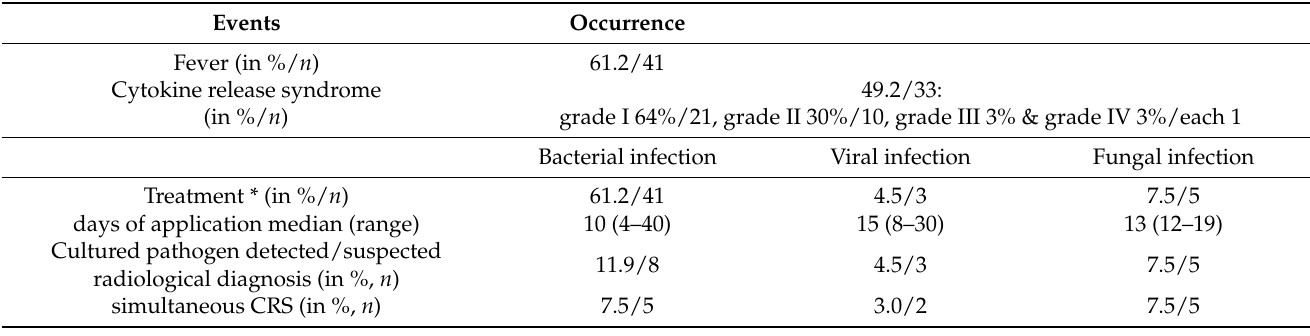
Table 3. Microbiological characteristics and events.